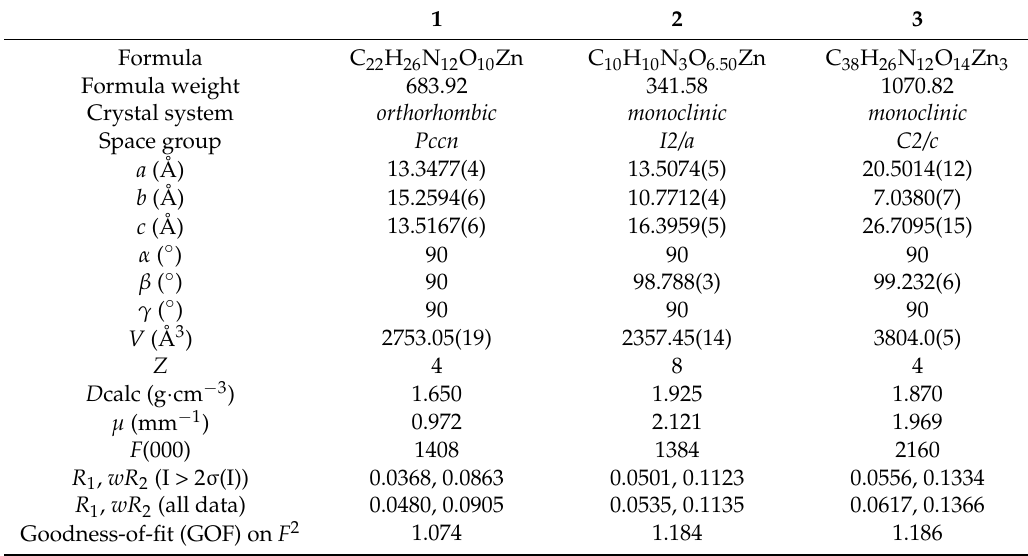
Table 1. Crystallographic parameters for compounds 1 – 3